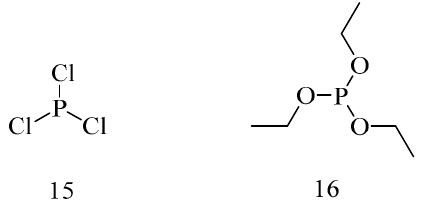
e.g., phosphorus trichloride 15 and triethyl phosphite 16 (Figure 7) [3,4].